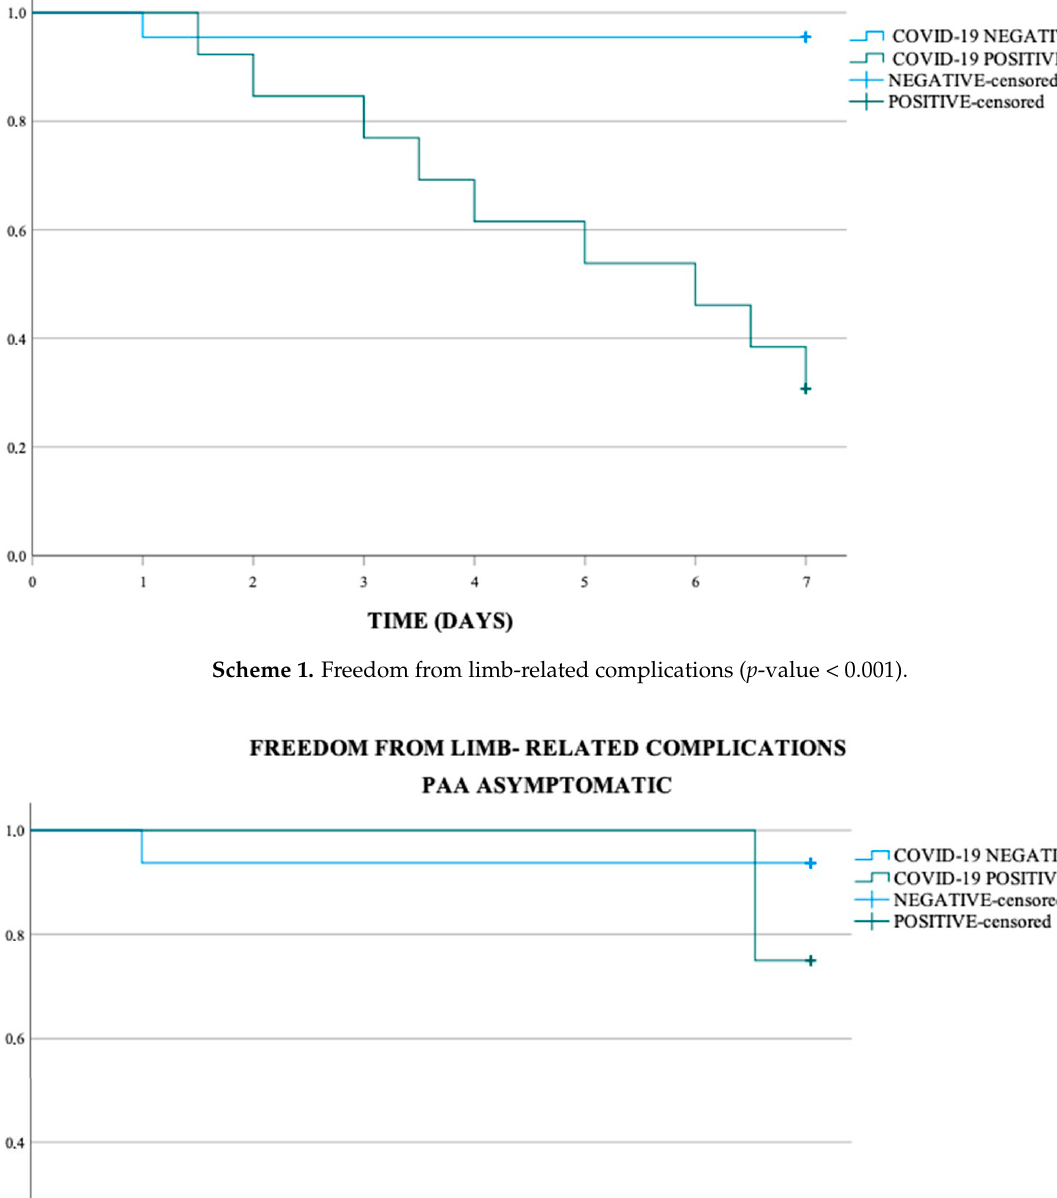
Scheme 2. Freedom from limb-related complications in asymptomatic PAA ( p -value < 0.001).